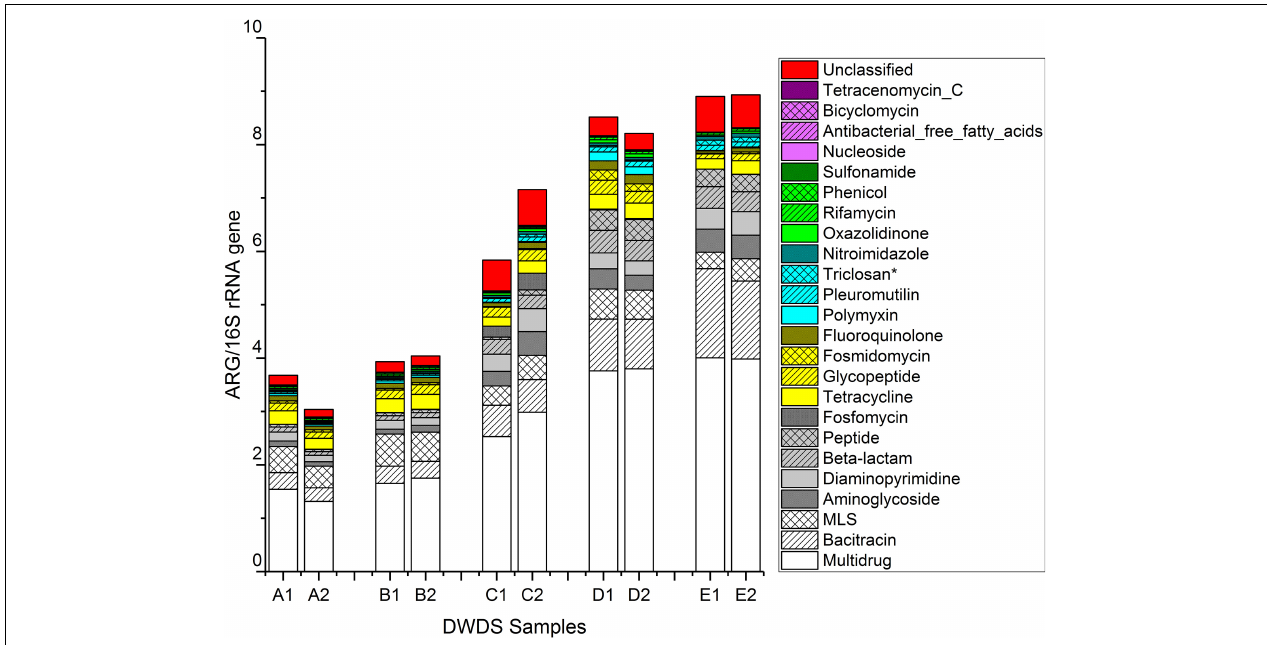
FIGURE 3 | The ratio between ARG reads obtained from metagenomic libraries and the16S rRNA amplicon library. *Genes conferring resistance to triclosan, an antimicrobial agent.